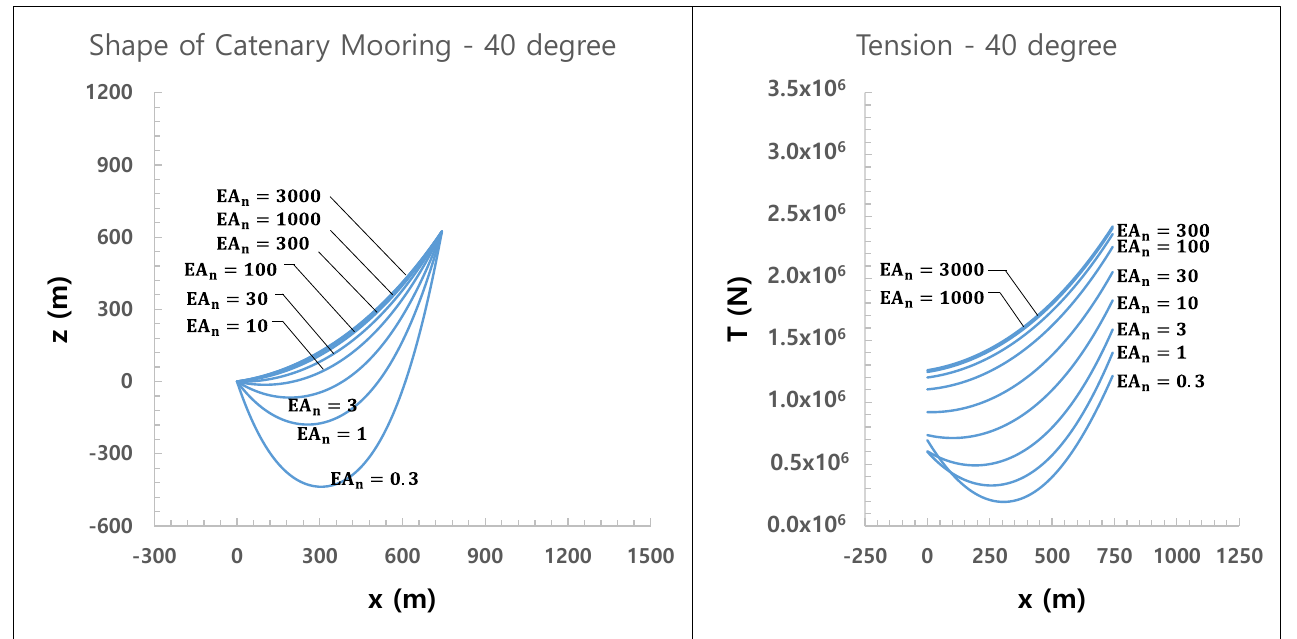
Figure 6. Results for static analysis of mooring line when q is 20°.